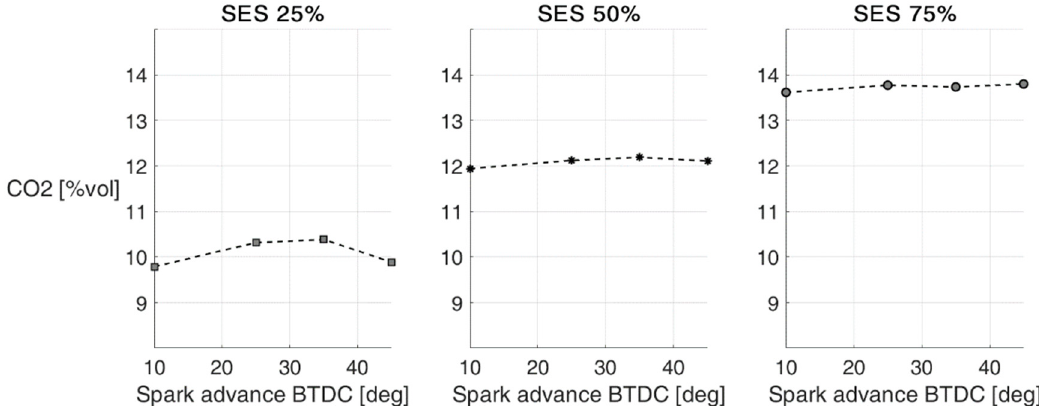
Figure 8. CO 2 [%vol] emissions for different spark advance and syngas energy share.